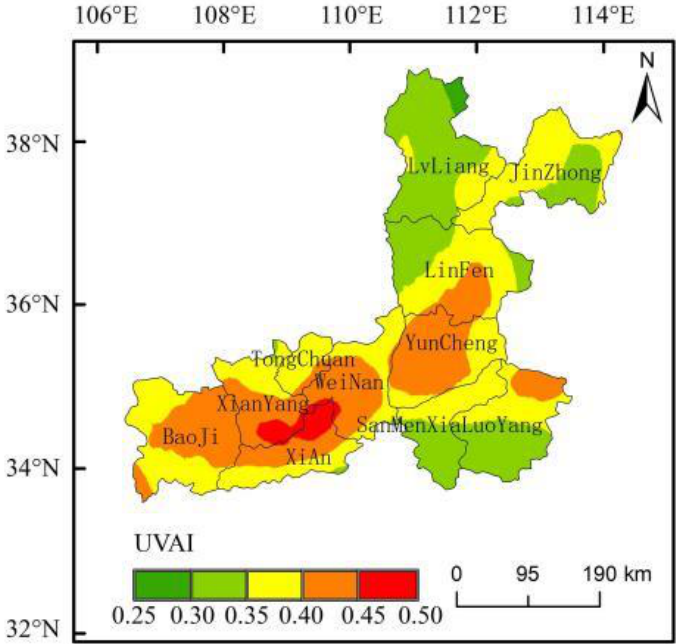
Figure 2. Spatial distribution of the daily ultraviolet aerosol index (UVAI) in the Fenwei Plain during 2012 – 2020.